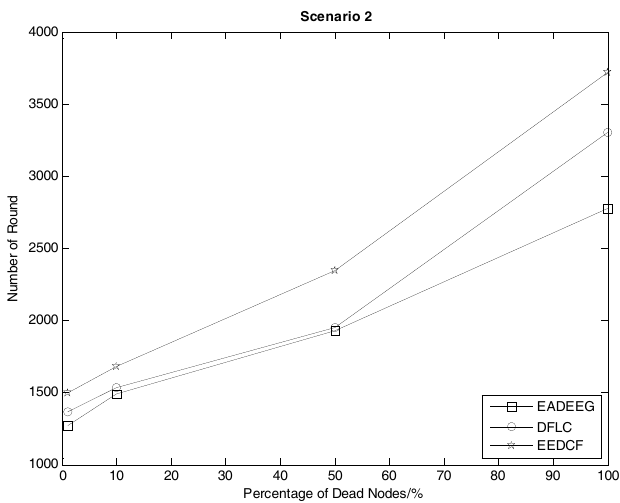
Figure 10. Number of round corresponding to different proportions of dead nodes of the network in Scenario 2.